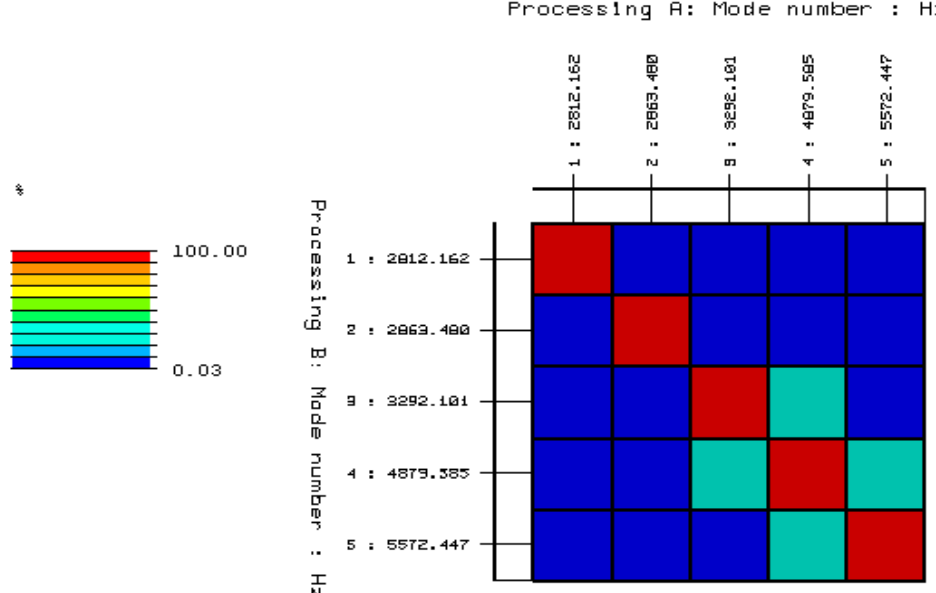
Figure 11. Validation of selected stable poles and the corresponding modes of free vibrations using the AutoMAC function.